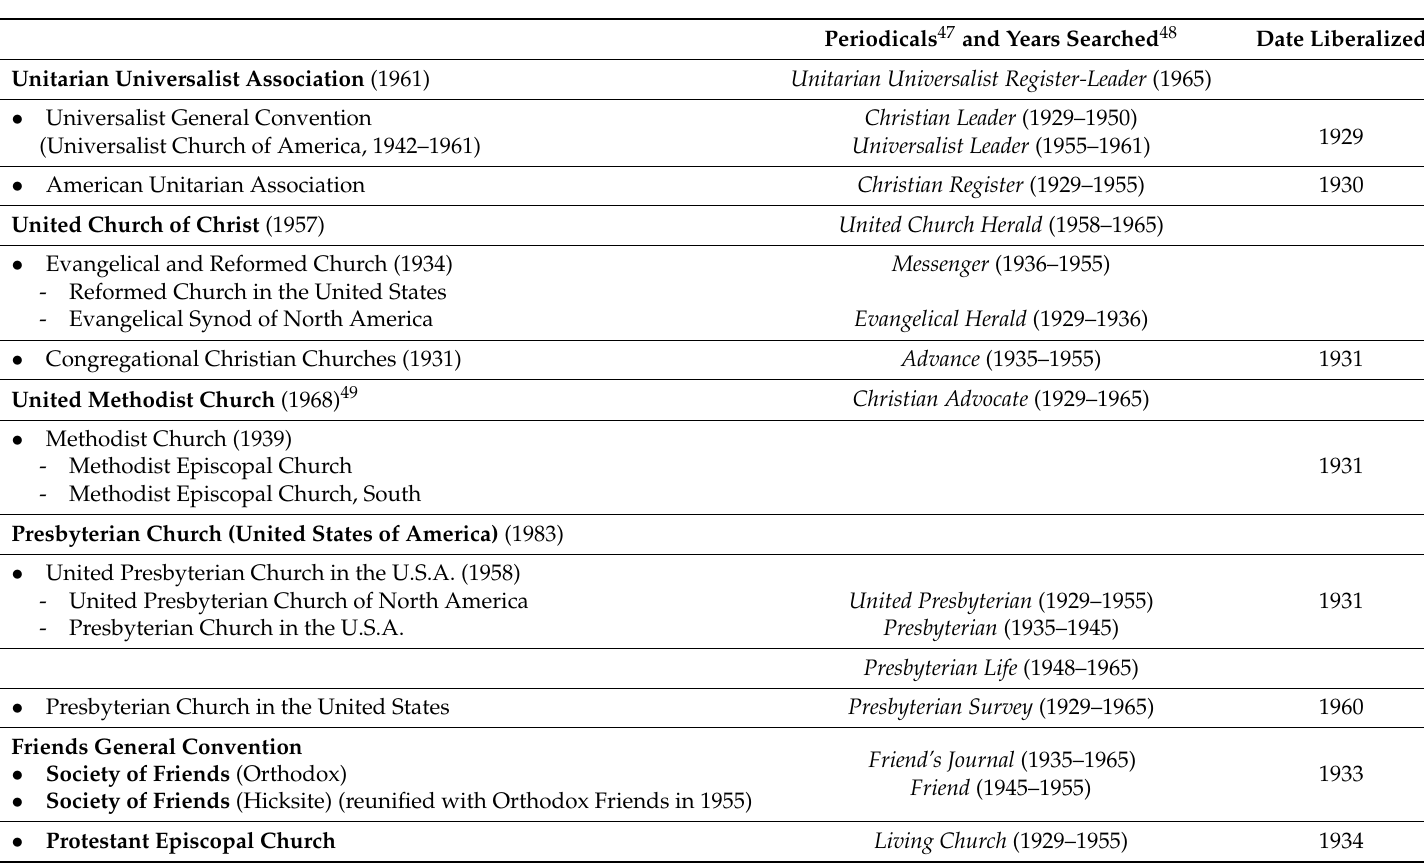
Table 1. America’s early religious birth control advocates (contemporary names, with predecessor groups and names in bullet